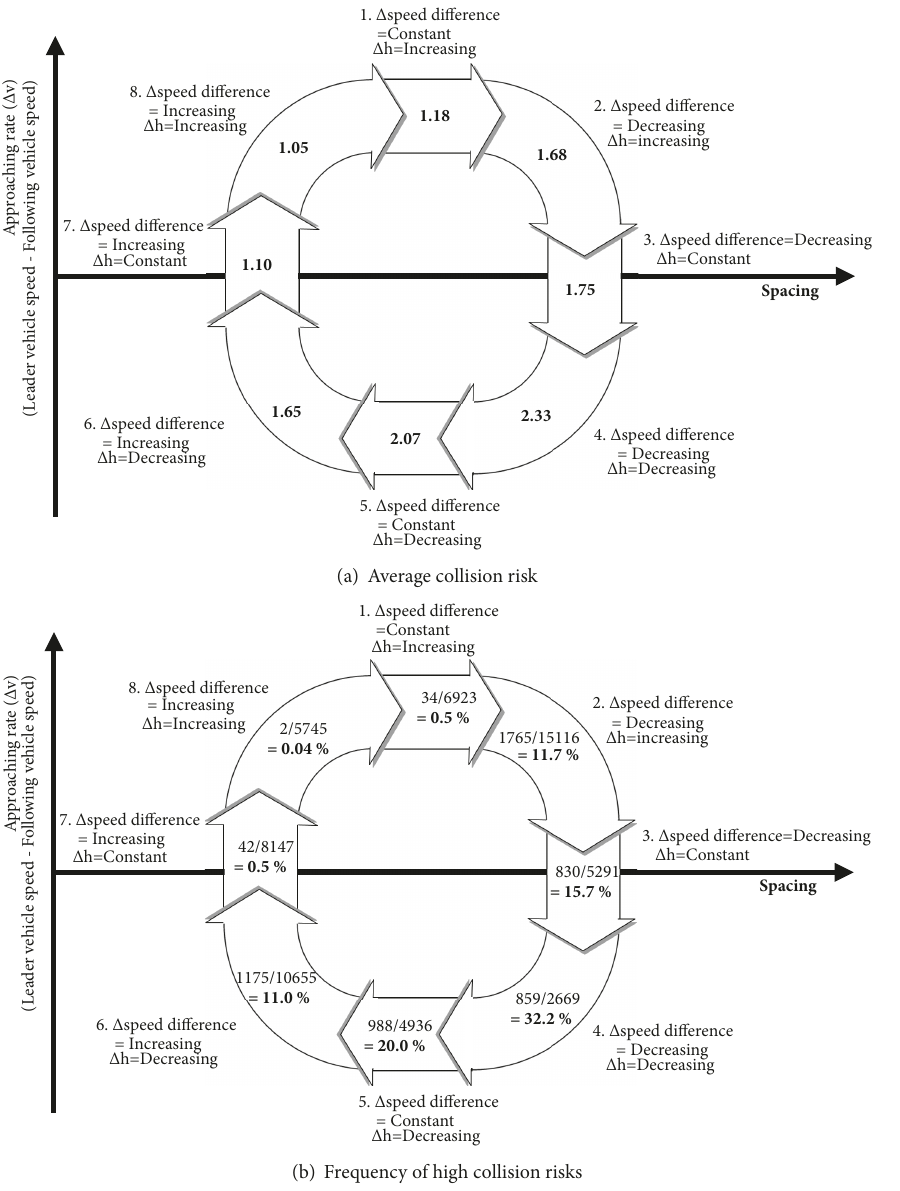
Figure 8: The DSSM trends on the average collision risk and frequency of high collision